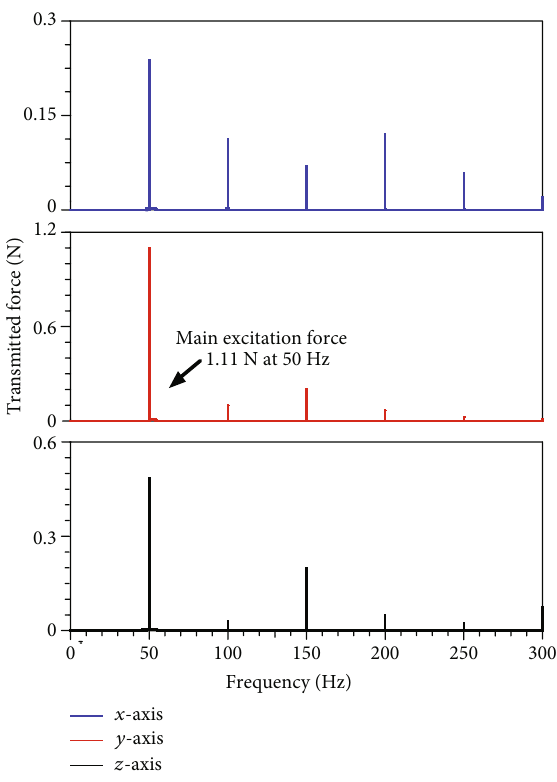
Figure 12: Microvibration measurement test results under rigidly clamped condition.